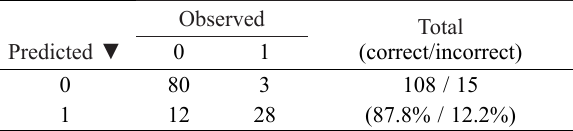
Table 7. Summary of the model predictive power